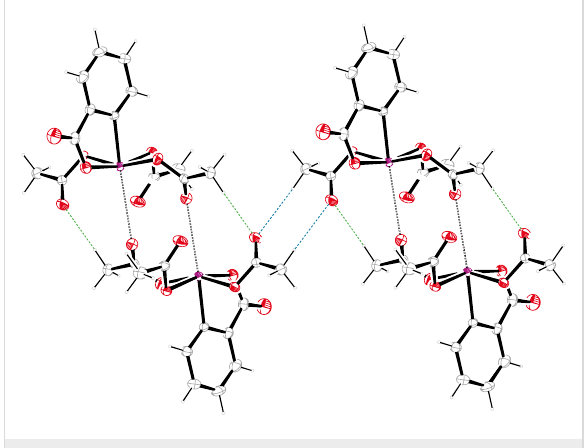
Figure 3: Supramolecular structure of 1 with halogen bonds and selected hydrogen bonds.